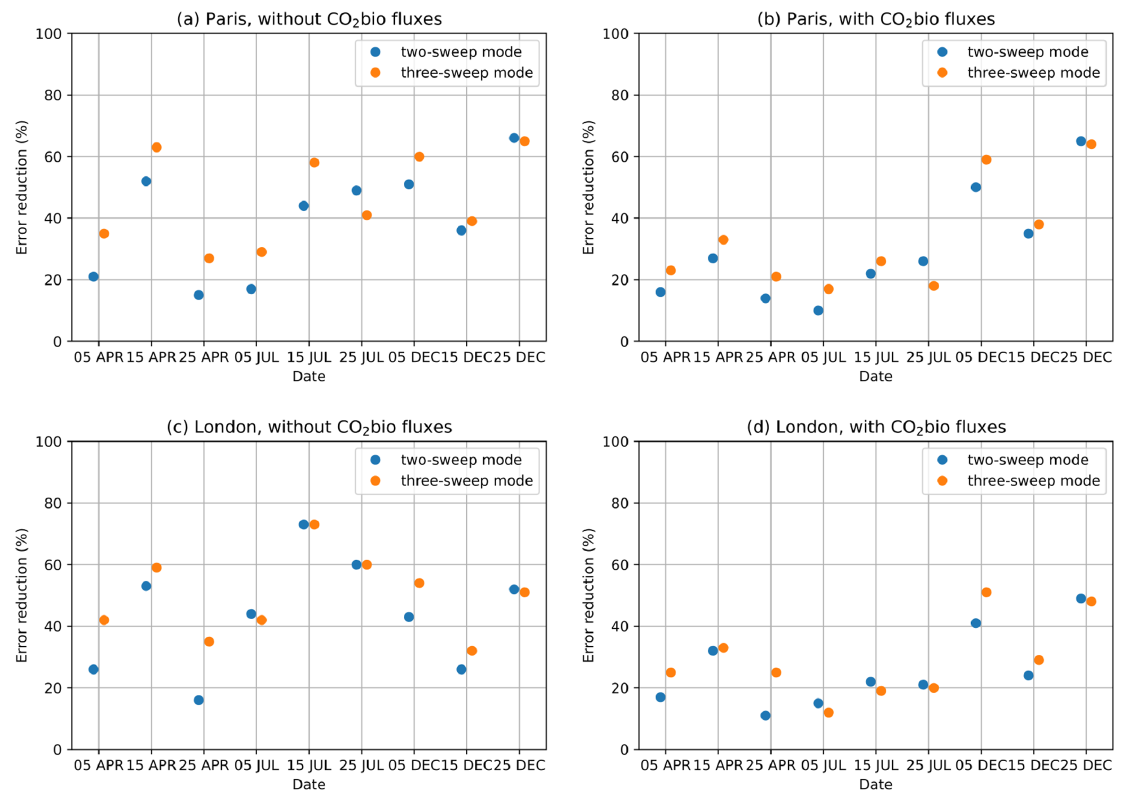
Figure 9. Similar to Fig. 8 but for the error reduction of the total city-scale emissions.